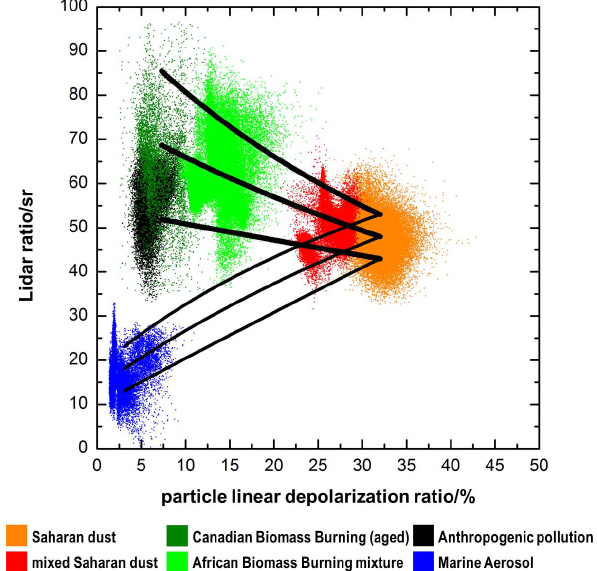
Fig. 6. Aerosol lidar ratio vs. particle linear depolarization ratio for various atmospheric aerosol types and mixing lines for Saharan dust and Canadian Biomass Burning Aerosol (thick lines), and for Saha- ran dust and Marine aerosol (thin lines). The central line in each case corresponds to the mean values as input for the calculation; the outer lines depict the maximum and minimum range when regard- ing the uncertainties of the input values.